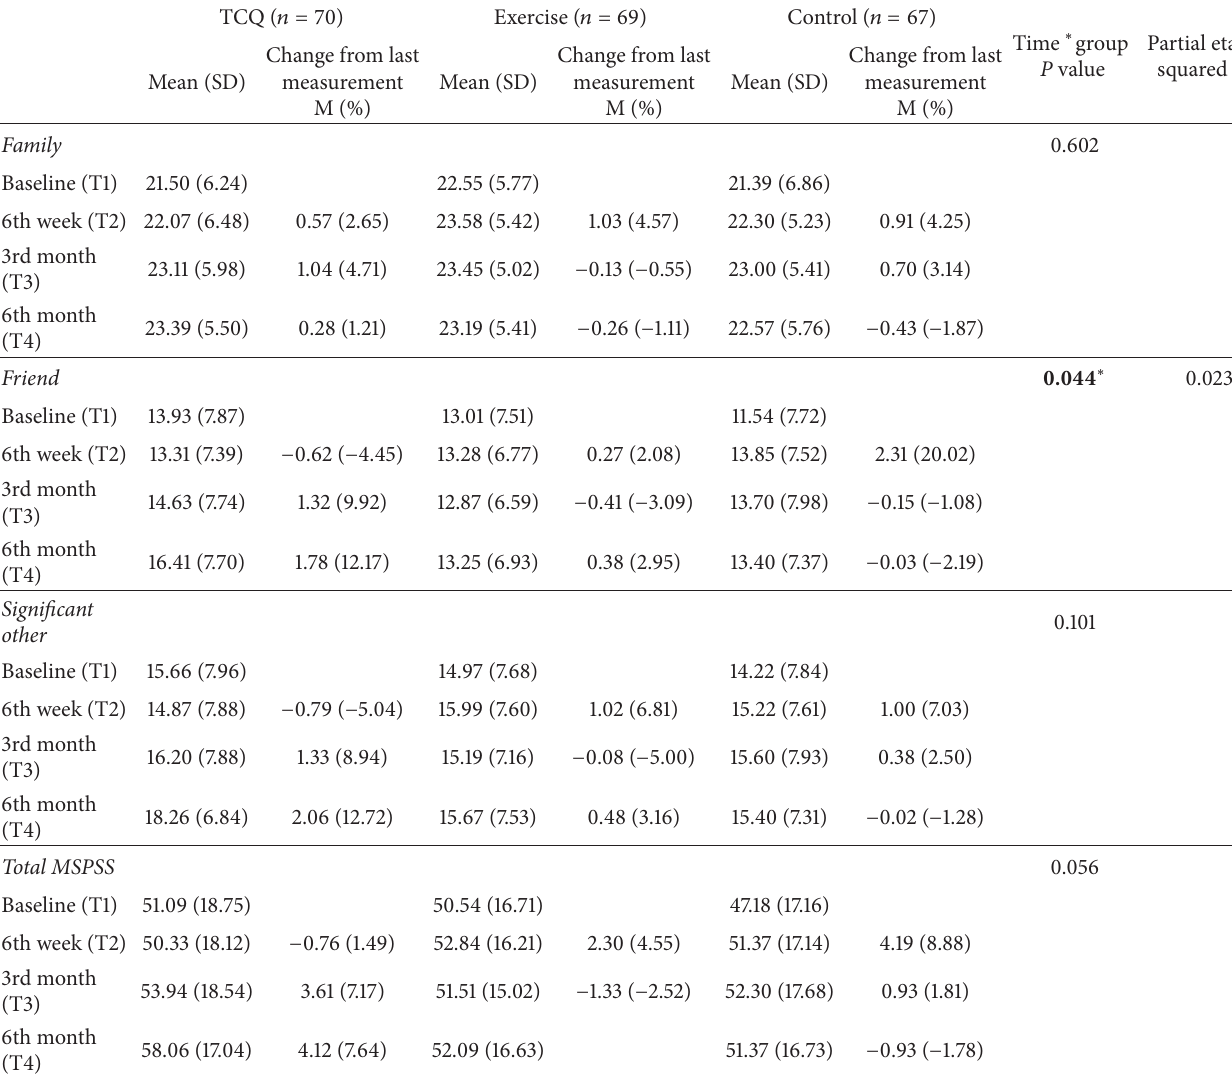
Table 3: Comparison of MSPSS at baseline, 6th week, 3rd month, and 6th